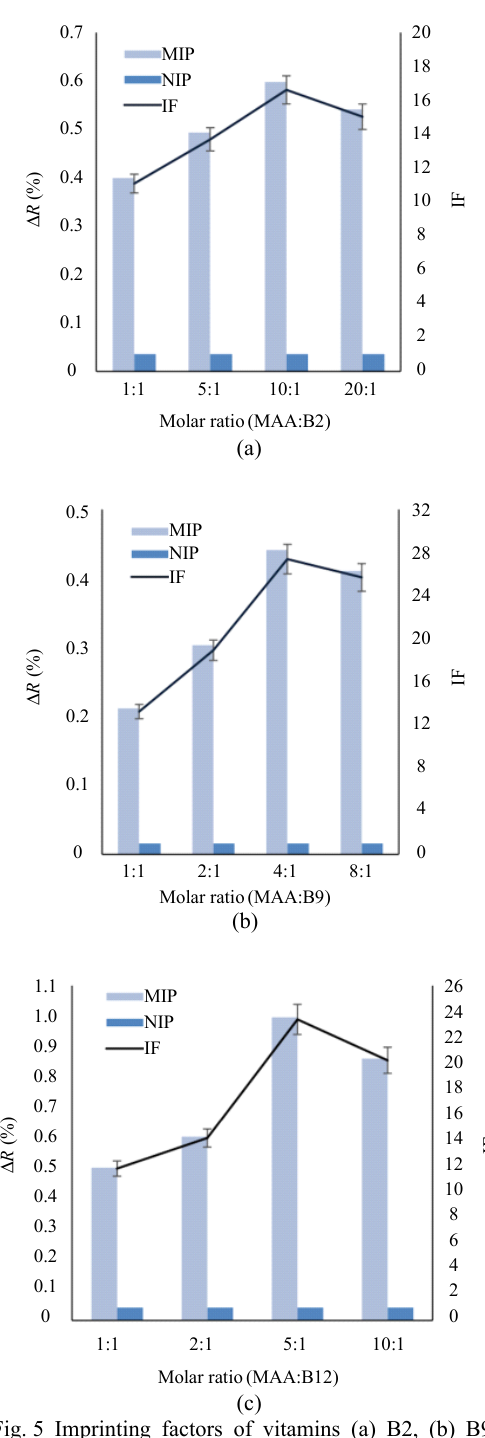
Fig. 5 Imprinting factors of vitamins (a) B2, (b) B9, and (c) B12 imprinted and non-imprinted polymers ( C vitamin B2 : 0.01 ng/mL, C vitamin B9 : 1.0 ng/mL, and C vitamin B12 : 0.1 ng/mL in all measurements).